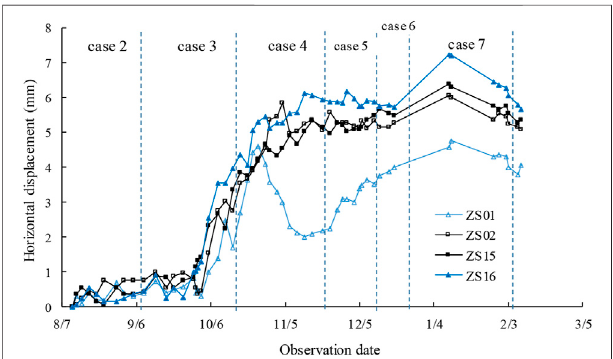
FIGURE 7 | Horizontal deformation of soldier pile